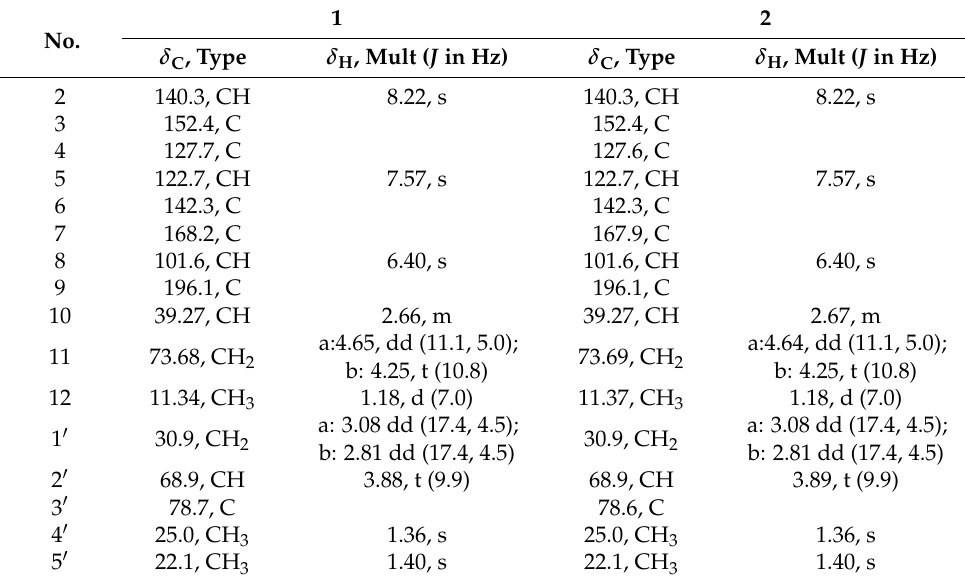
Table 1. 1 H (400 MHz) and 13 C (100 MHz) NMR data for compounds 1 and 2 (CDCl 3 ).